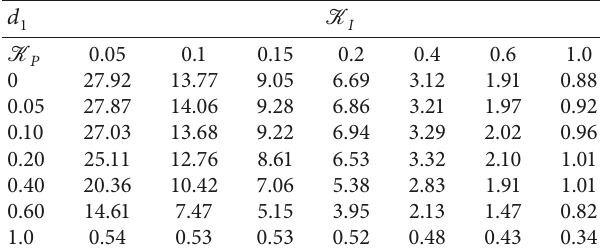
Table 3: The MAUB of d [45].